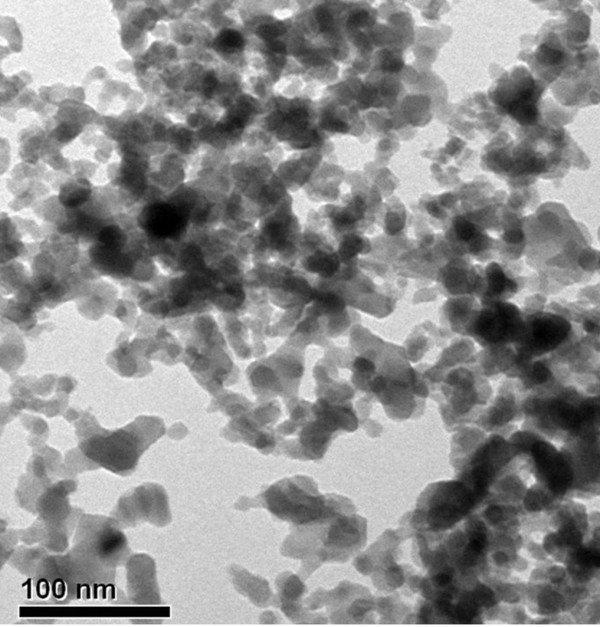
TEM image of Al2O3 additives.